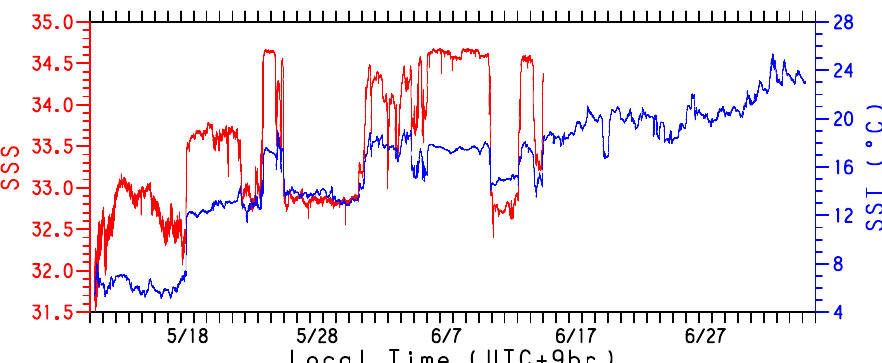
Figure 7. Time series of SSS (red line) in practical salinity scale along the WG track. The abscissa is local time (UTC + 9h) during the observation period from 11 May to 5 July 2022. For comparison, SST ( ◦ C) time series is shown by blue